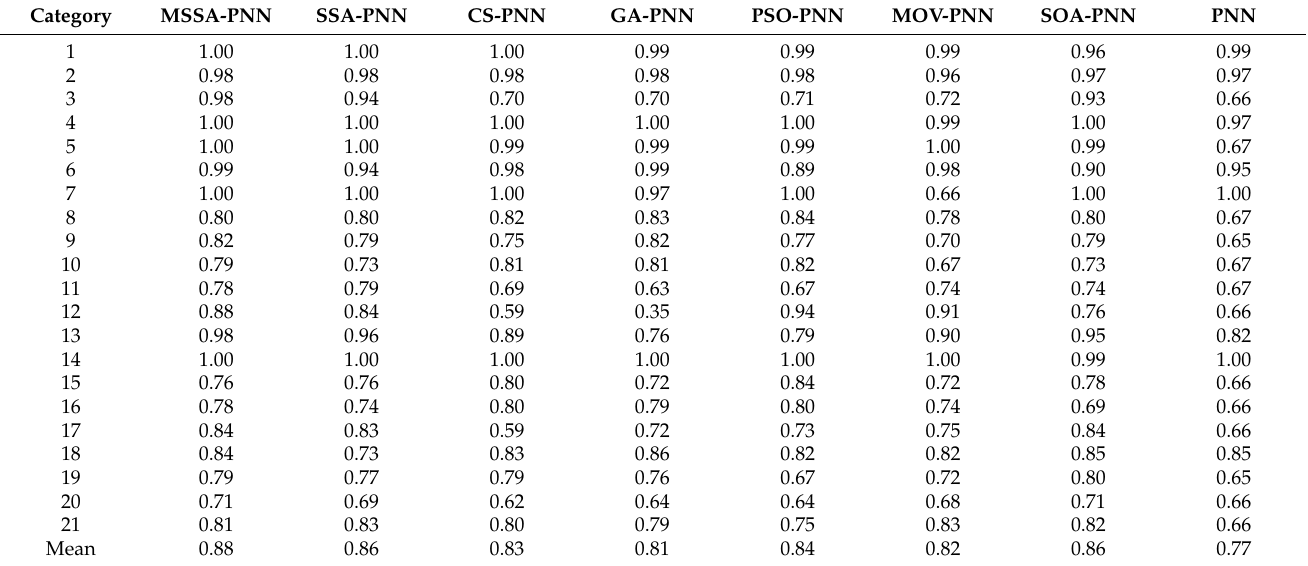
Table 7. Troubleshooting rate of different optimized PNN